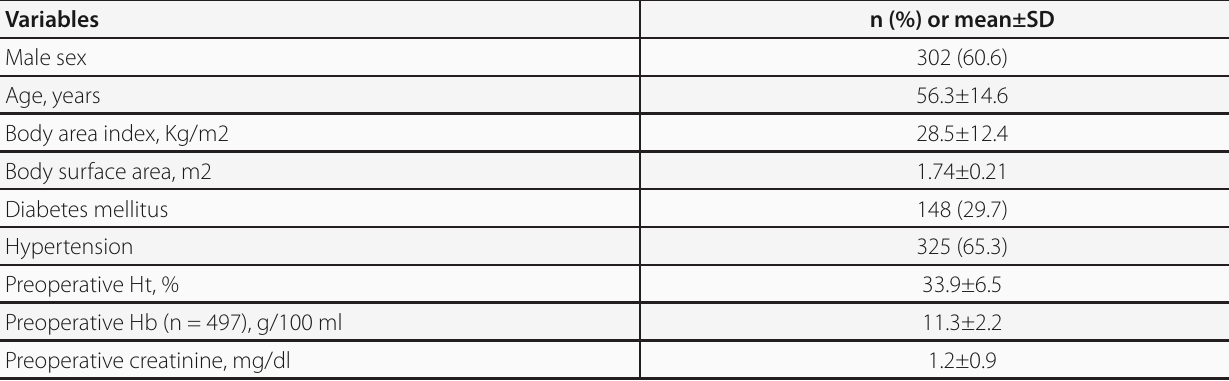
Table 1. Patients’ demographic and clinical profile (n = 498).